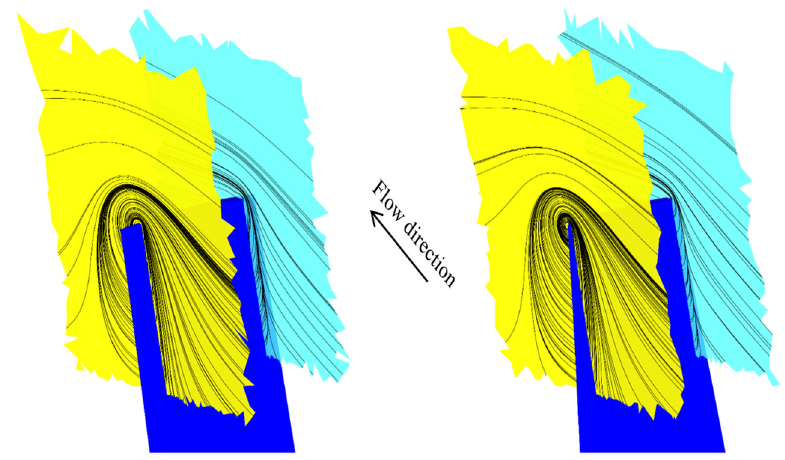
Figure 18. The tip streamlines of the base ( left ) and designed ( right ) blades.